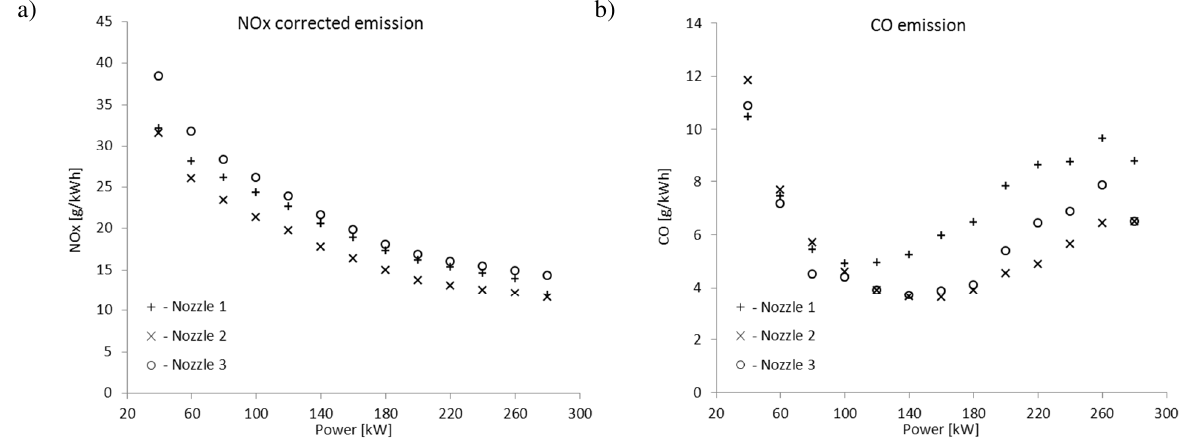
Fig. 5. Emission of the NO x and the